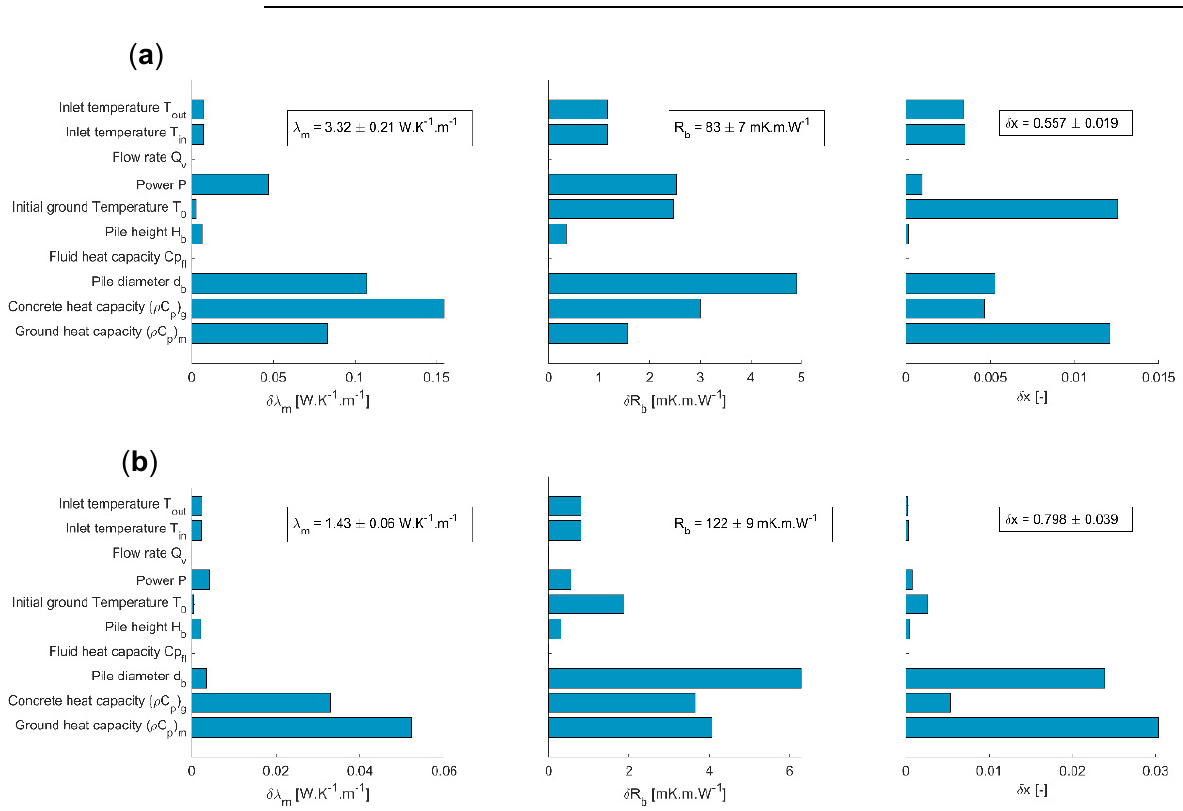
(cid:3105)(cid:3025) (cid:3284) Δ𝑦 ∆ y (cid:3037) in Equation (24)) for ( a ) set B and ( b ) set C. Figure 8. Sources of error (terms ∂ X i ∂ y j in Equation (24)) for ( a ) set B and ( b ) set (cid:3105)(cid:3052) (cid:3285) j